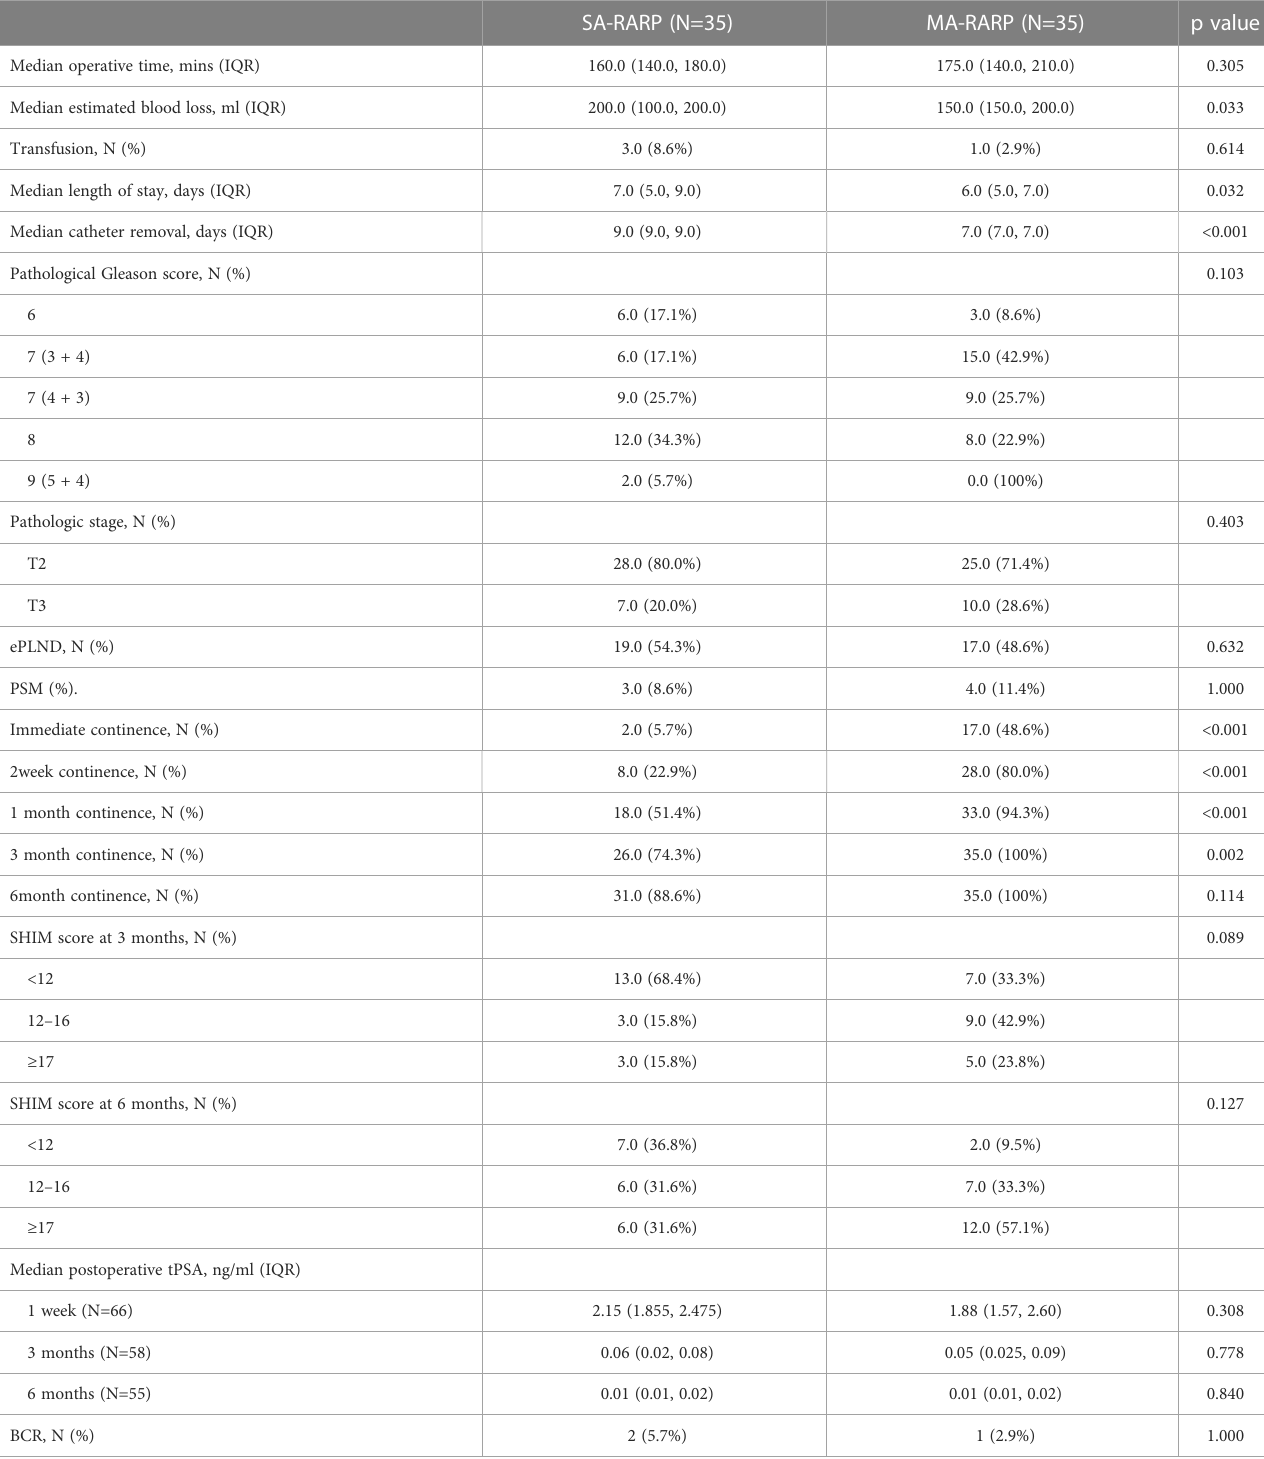
TABLE 3 Post-matching perioperative and postoperative outcomes of 35 patients who underwent SA-RARP vs 35 patients who underwent